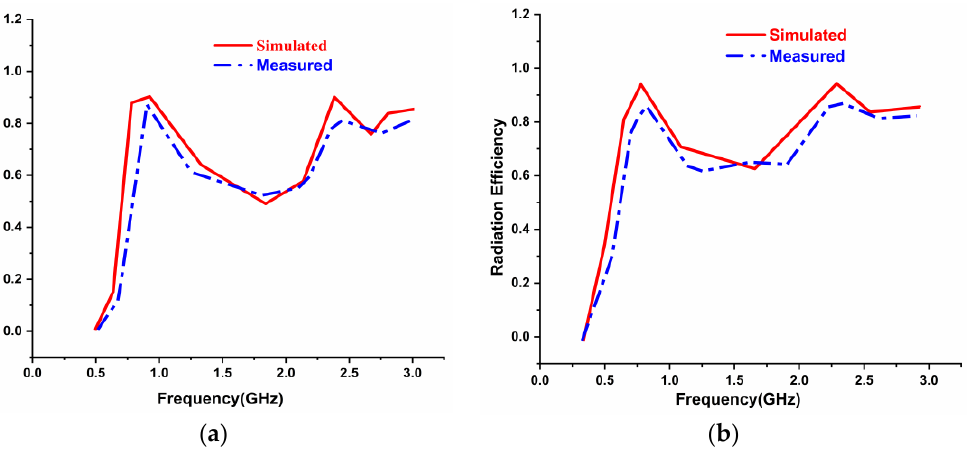
Figure 19. Radiation Efficiency results of the antenna ( a ) without the AMC Backing ( b ) with the AMC Backing.